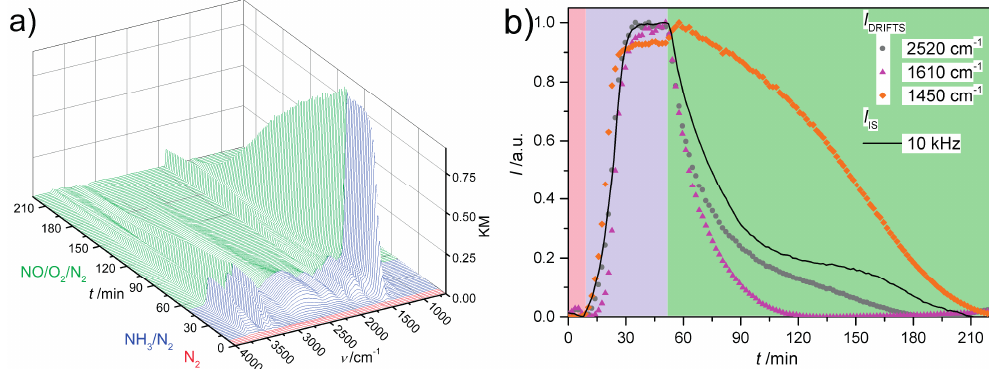
Figure 18. DRIFTS-IS study over a Fe-ZSM-5 SCR catalyst at 100 °C. ( a ) DRIFT spectra for Fe-ZSM-5 zeolite exposed to N 2 (red), N 2 /NH 3 mixture (blue) and NO/O 2 mixture (green) in sequence; ( b ) comparison of normalized I IS (green line) and I DRIFTS (empty symbols) obtained under different gas conditions. The Fe-ZSM-5 catalyst was a commercial catalyst from Clariant, and with a SiO 2 /Al 2 O 3 ratio of 30. Figures are adapted from [67], with permission from